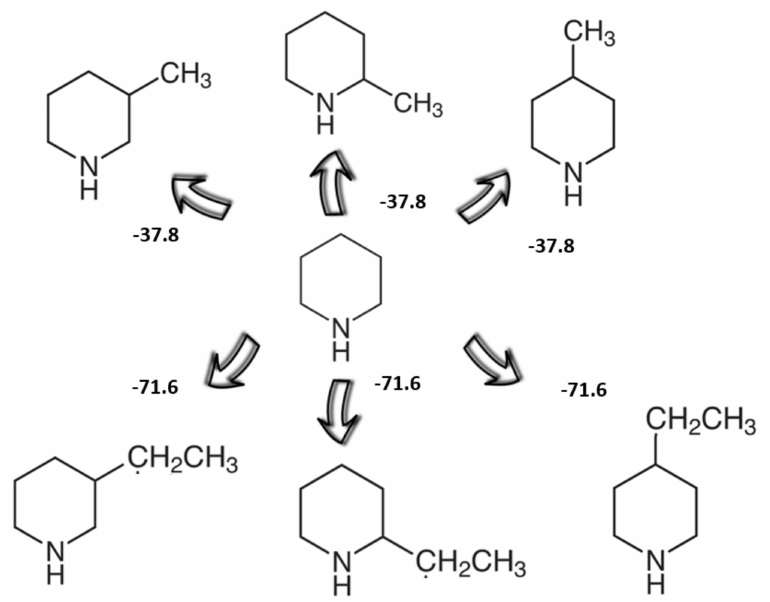
Figure 3. Evaluation of increments H → CH 3 for ∆ f H o m (liq) responsible for exchange of H-atom in piperidine ring with the methyl group. The averaged increment ( − 37.8 ± 0.8) kJ · mol − 1 for the H → CH 3 substitution was derived as it shown in Figure S4. The increment H → CH 2 CH 3 was calculated based on the enthalpies of formation of piperidine, 4-ethyl-piperidine (numerical data are given in Table S6).